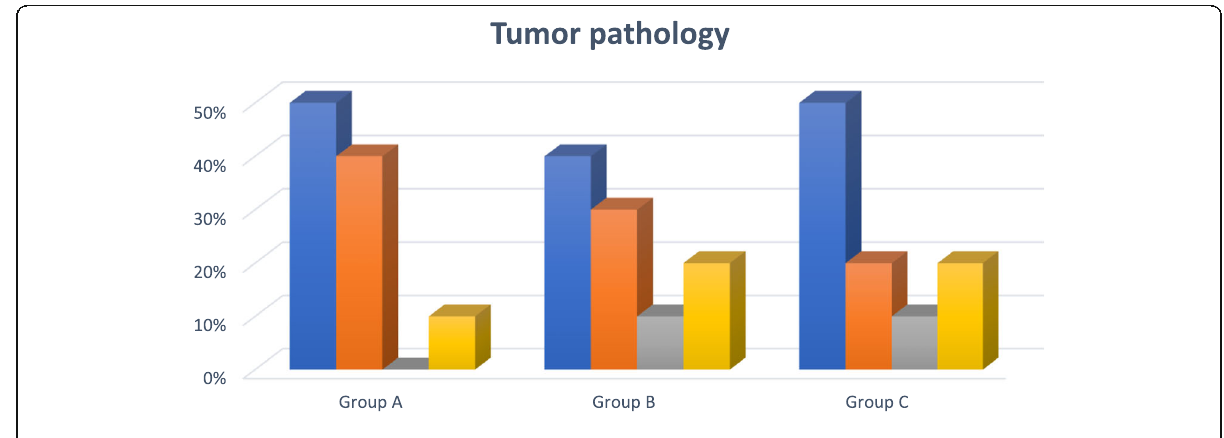
Fig. 1 Tumor pathology of the studied